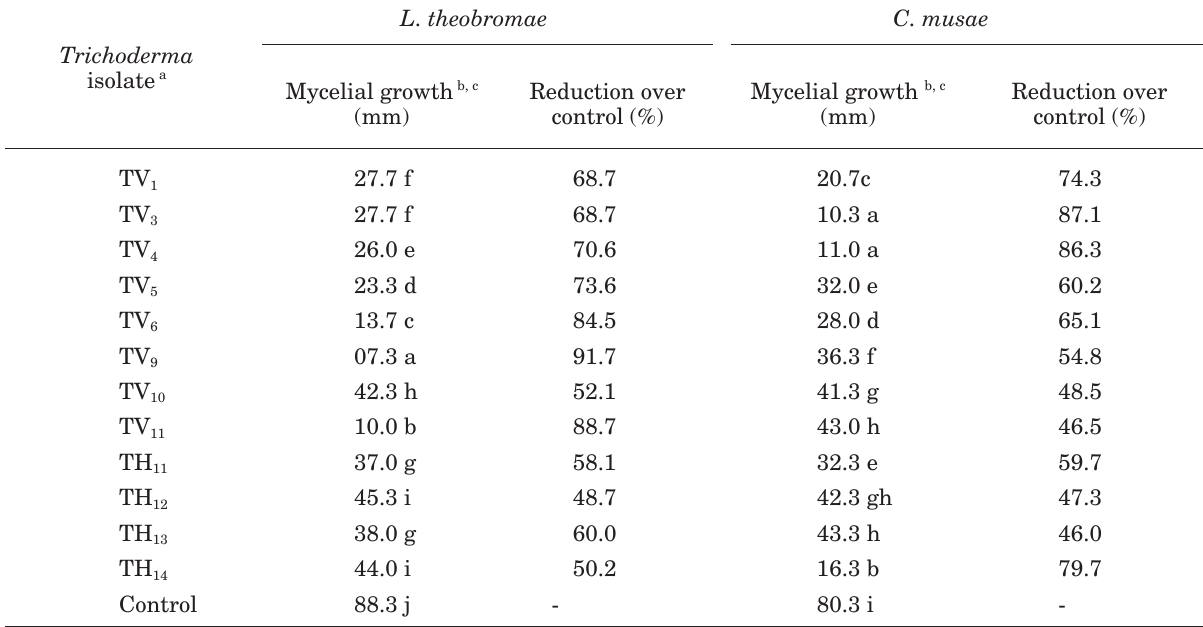
Table 1. Mean mycelium growth of Lasiodiplodia theobromae and Colletotrichum musae and proportional reductions (compared with controls) for native Trichoderma isolates tested in vitro.